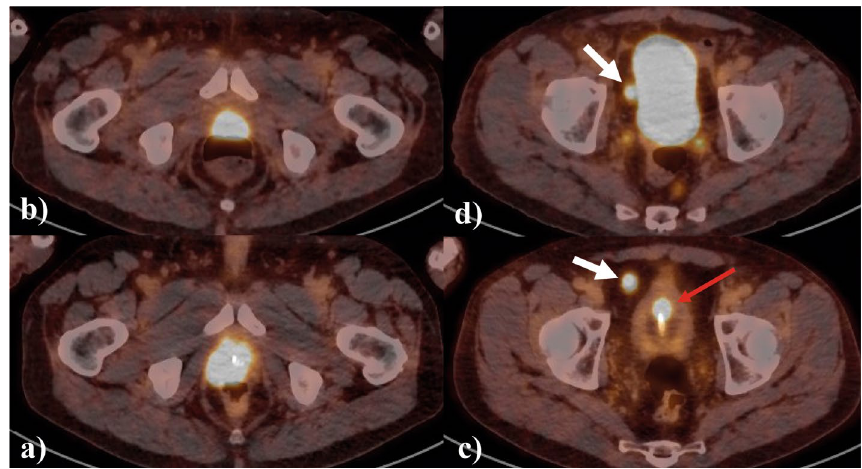
Fig. 4 Patient 01 a prostate lesion on pre-surgery PSMA PET/CT; b prostate bed residual lesion on post-surgery PSMA PET/CT; c para-vesical lymph node on pre-surgery PSMA PET/CT; d para-vesical lymph node on post-surgery PSMA PET/CT (white arrow); red arrow represents a lesion in urinary bladder wall